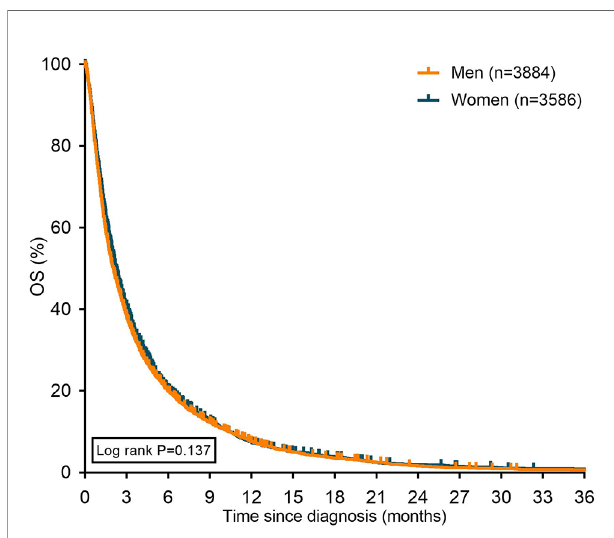
FIGURE 2 | Kaplan Meier curves displaying overall survival in patients with metastatic pancreatic cancer strati fi ed for sex. OS: overall survival.